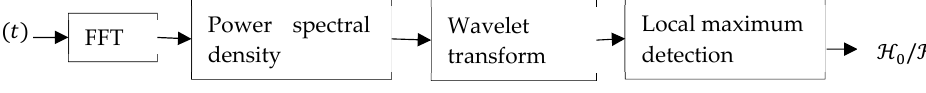
Figure 6. Block diagram of wavelet based spectrum sensing